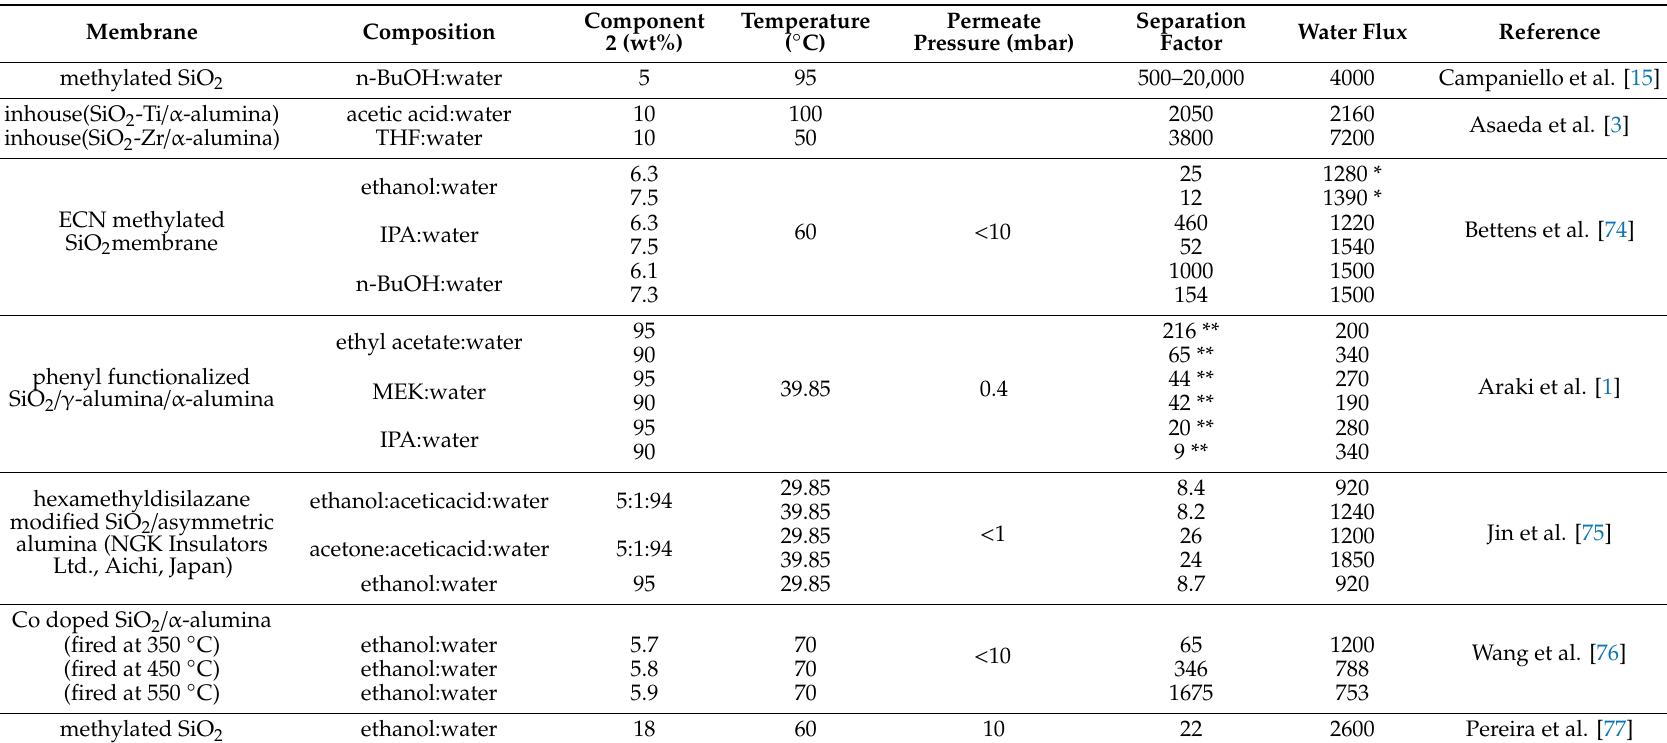
Table 6. Pervaporation performance of modified or doped silica membranes for various water–organic mixtures.